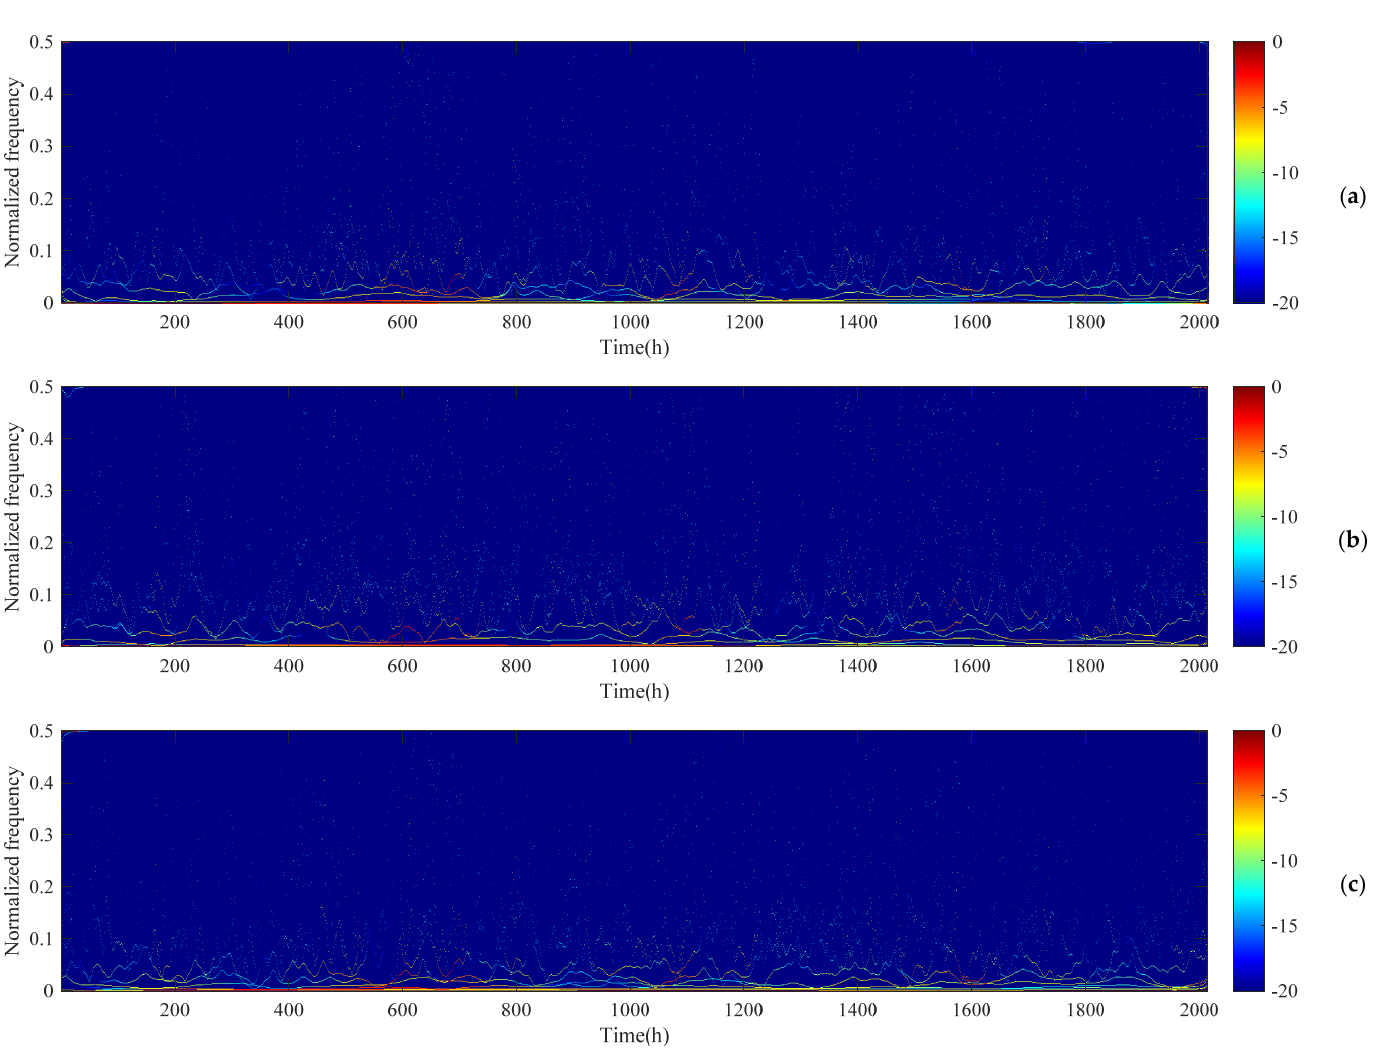
Figure 5. The Hilbert spectrum of the PM 10 concentration data series measured at ( a ) Site 1, ( b ) Site 2, and ( c ) Site 3.